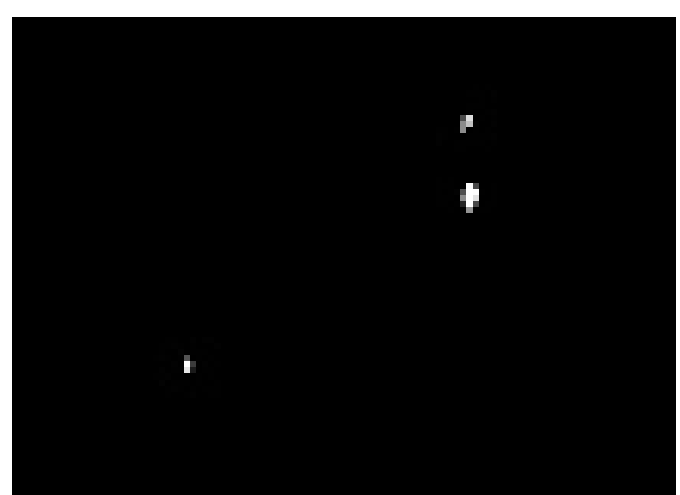
Figure 10. Enlarged view of the target the fourth frame of pre-ViBe method (108 ×